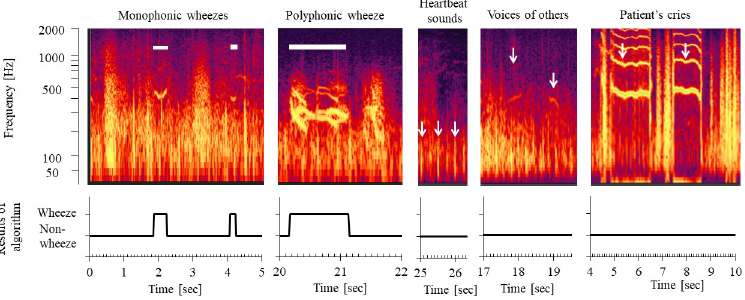
Fig 4. Automatic discrimination of wheezes from other sounds using the newly developed wheeze detection algorithm for children.